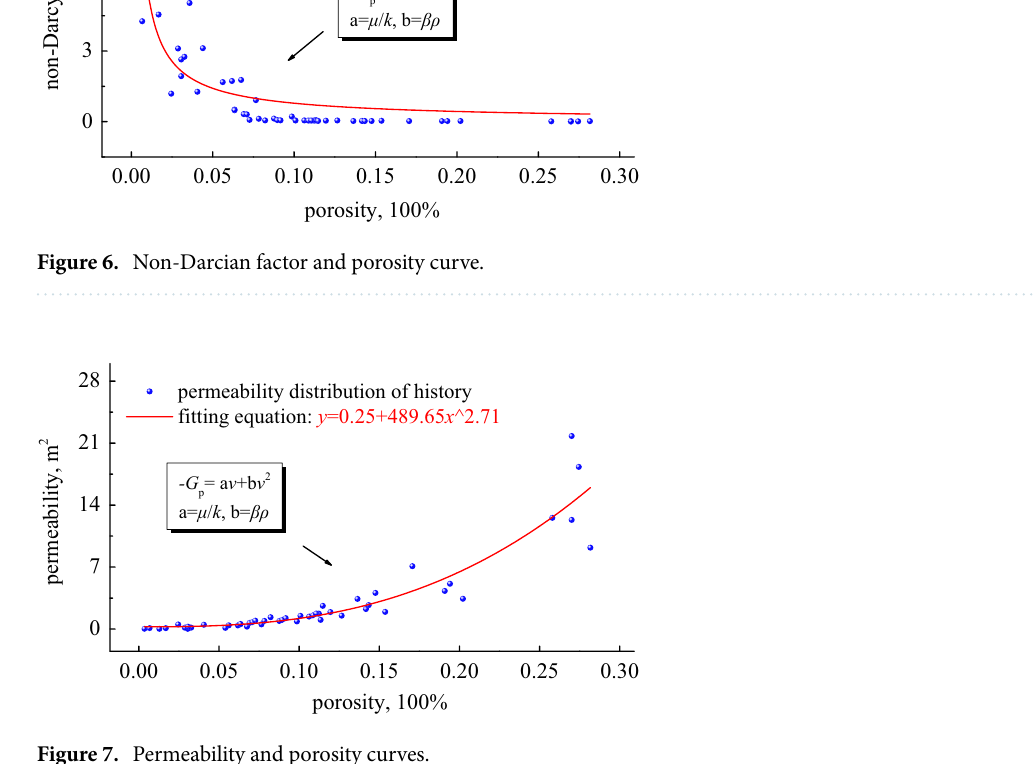
Figure 7. Permeability and porosity